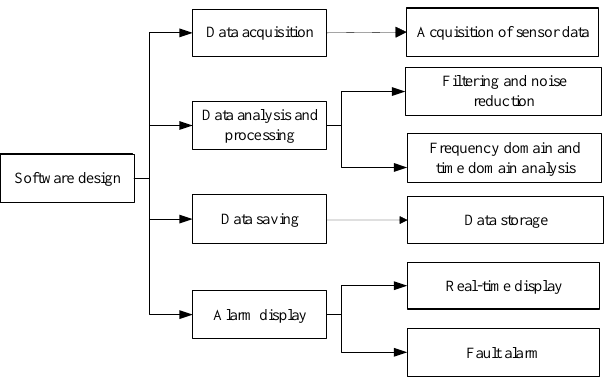
Figure 6. Overall architecture of software design.